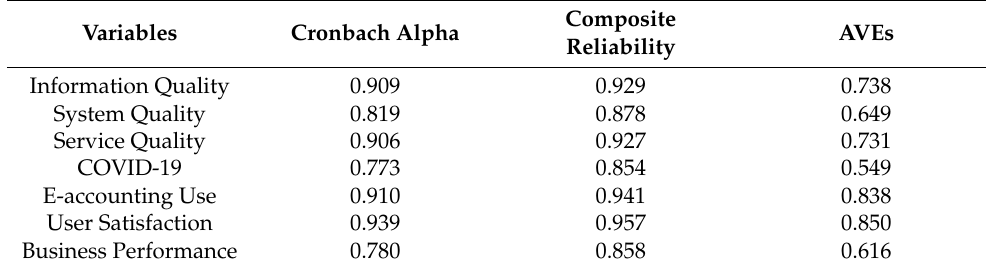
Table 1. Convergent validity